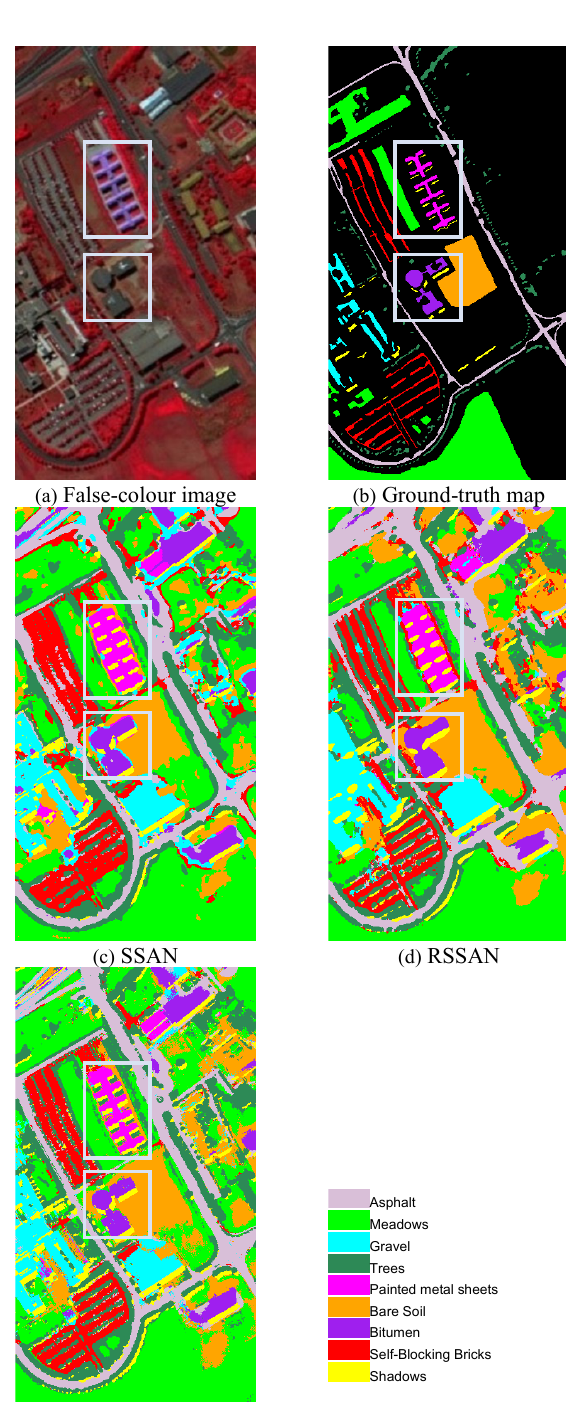
Figure 4. Classification maps using different